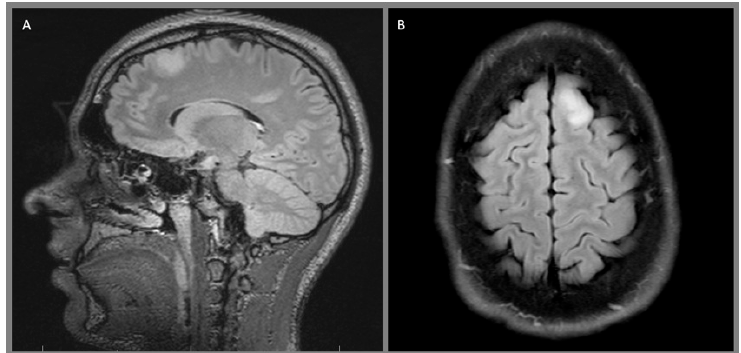
Figure 1. Left frontal diffuse astrocytoma, WHO 2: ( A ) sagittal T2 Fluid-attenuated inversion recovery (FLAIR ) and ( B ) axial T2 FLAIR sequences demonstrate a diffusely infiltrating, hyperintense lesion in the left superior frontal gyrus.